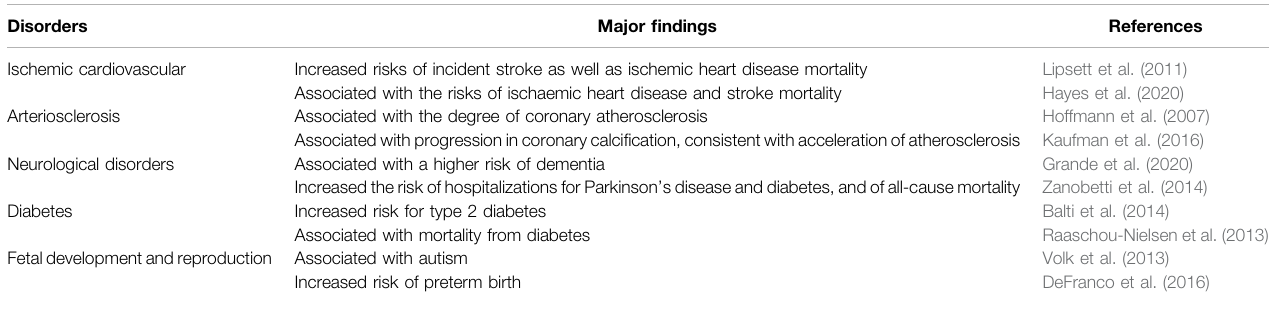
TABLE 1 | Epidemiological studies linking PM 2.5 exposure with extrapulmonary